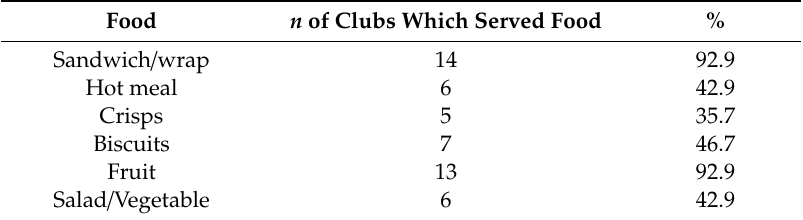
Table 2. Descriptive information on the number and percentage of Fit and Fed pilot clubs ( n = 14 due to missing data) serving di ff erent types of